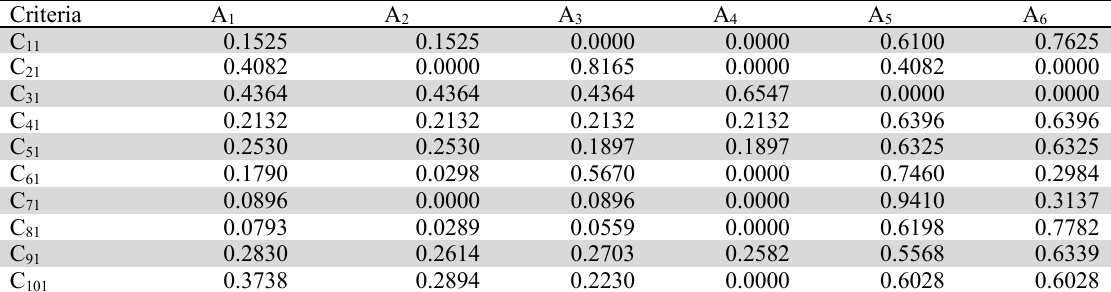
The case study normalised decision matrix for the technical criteria